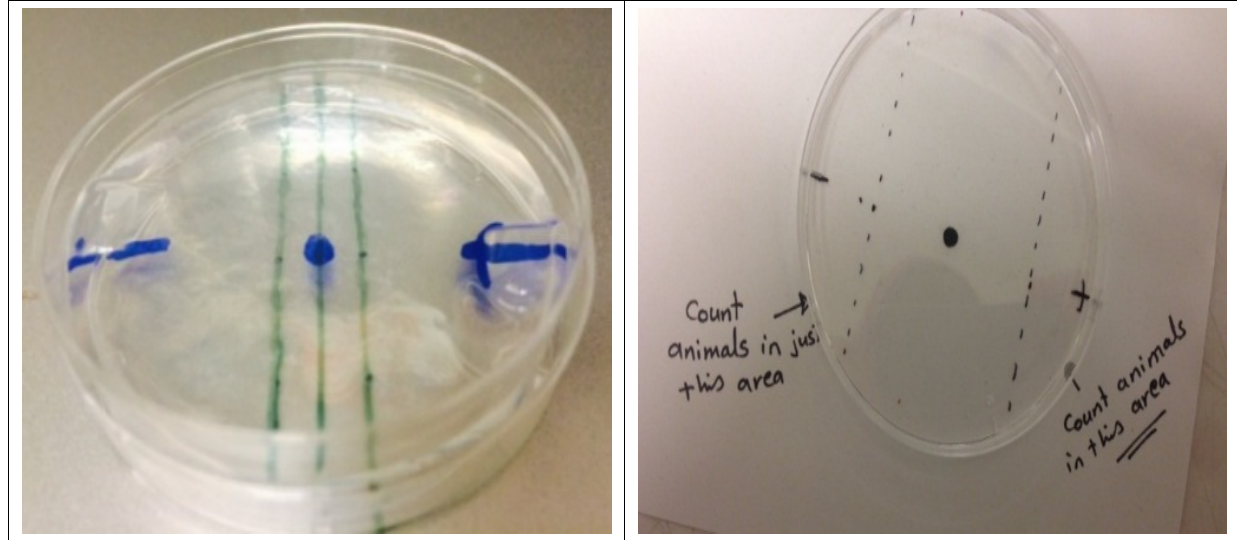
Figure A1. Images showing agar plates for chemotaxis assays for G. pallida (left; 3 cm plate) and for C. elegans (right; 9 cm plate).